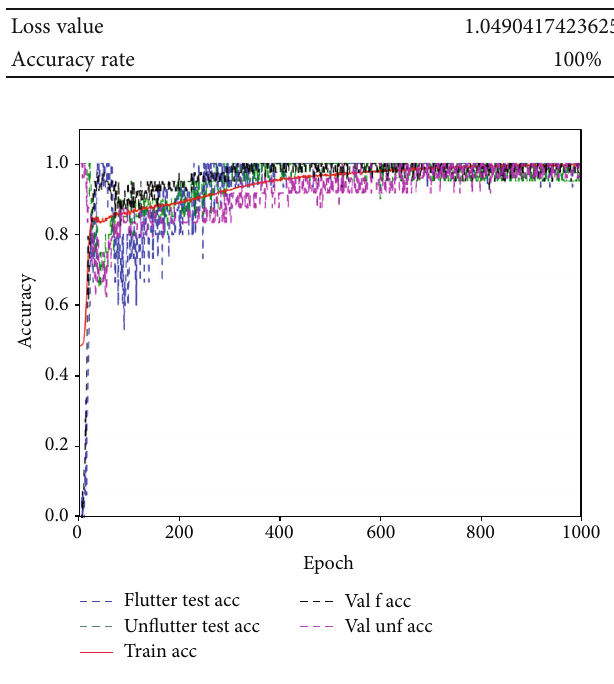
Figure 13: STFT-CNN accuracy curve.